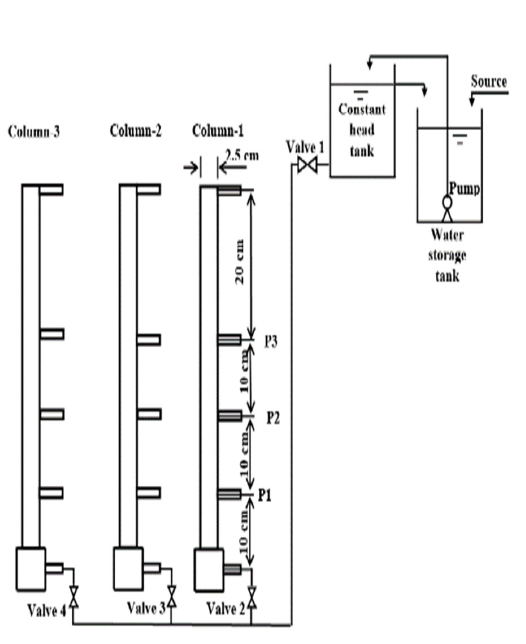
Fig. 1. Laboratory-scale column setup.